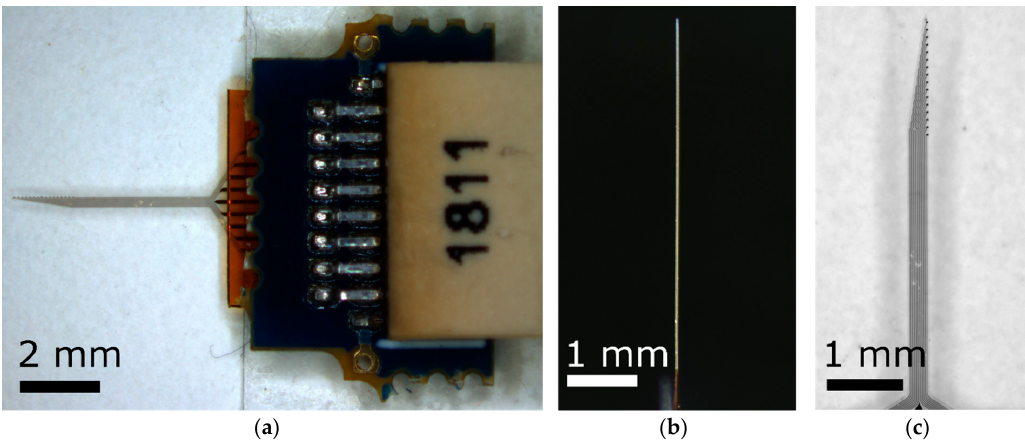
Figure 1. Optical images of shape memory polymer (SMP) probes. ( a ) Device with Omnetics connector, ( b ) side view demonstrating a straight shank prior to implantation, ( c ) tip with sputtered iridium oxide film (SIROF)-coated electrodes.